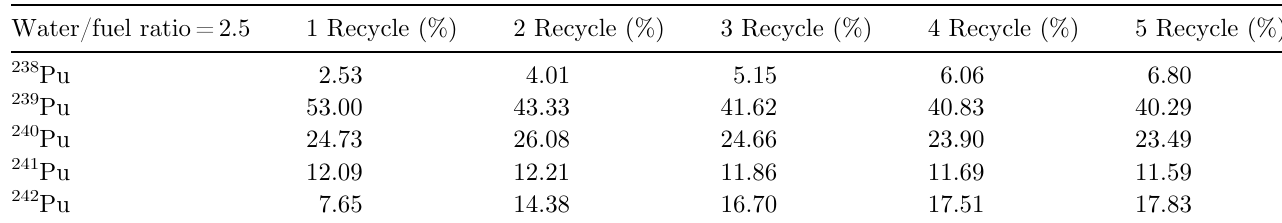
Table 6. Plutonium isotopic composition for FA with water/fuel ratio = 2.5. Water/fuel ratio = 2.5